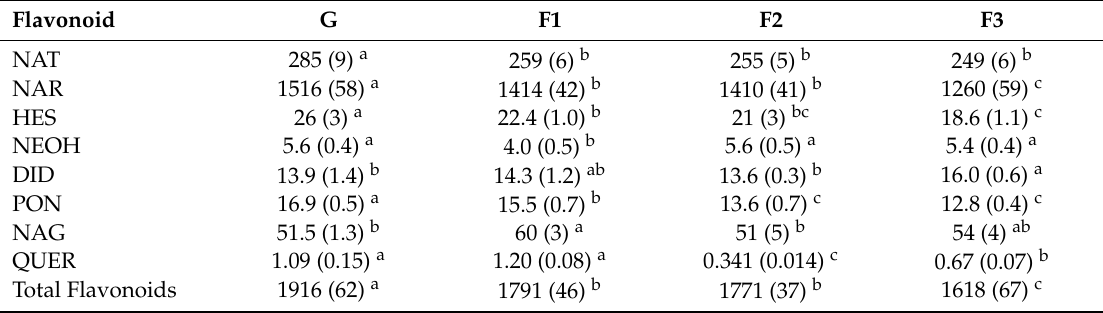
Table 6. Mean values in mg / 100 g (with standard deviation) of flavonoids (narirutin, naringin, hesperidin, neohesperidin, didymin, poncirin, naringenin, and quercetin) analyzed in grapefruit powder (G) and each grapefruit freeze dried formulation (F1, F2, and